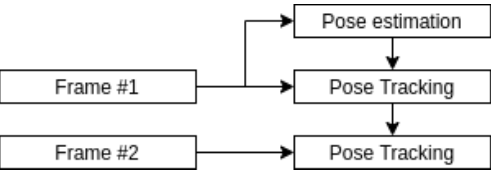
Figure 1. Pose estimation